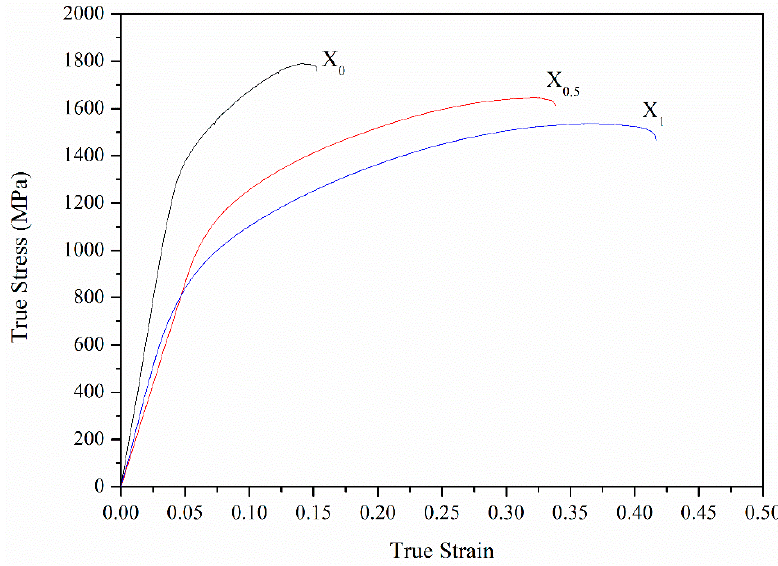
Figure 12. True stress–strain curves obtained from compression tests for the X 0 , X 0.5 , and X 1 as-cast alloys.